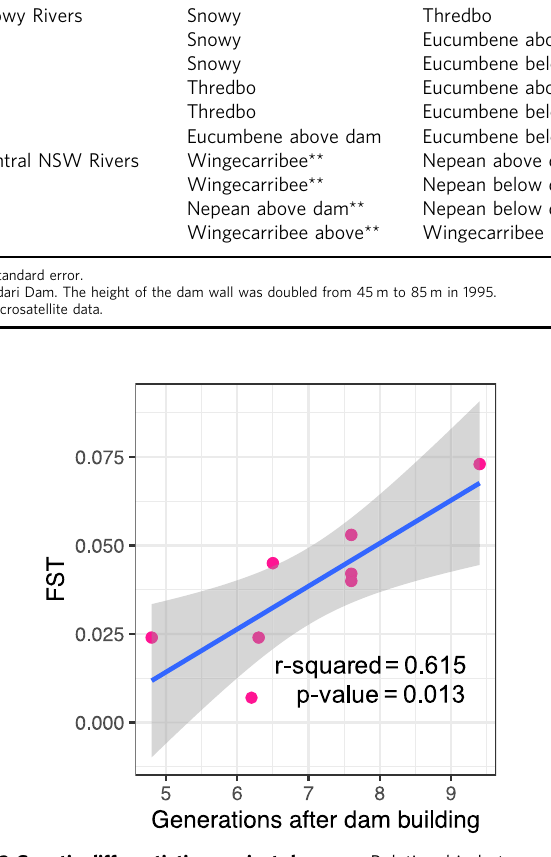
Fig. 2 Genetic differentiation against dam age. Relationship between genetic differentiation ( F ST ) between platypus groups separated by major dams ( n = 8 major dams) and the number of platypus generations (7.9 years 68 ) since the building of the dam. Genetic differentiation increased at a rate of 0.011 per